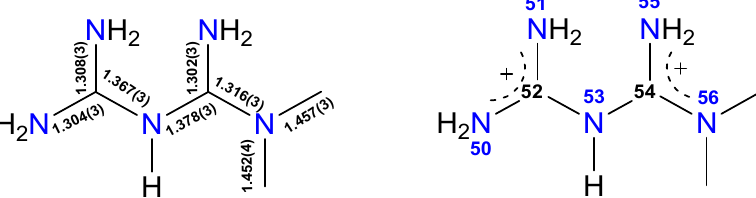
Figure 3. Bond lengths in Å ( left ) and delocalized structure of the dicationic metformin H 2 Mf 2+ ( right ) showing the atom numbering scheme.